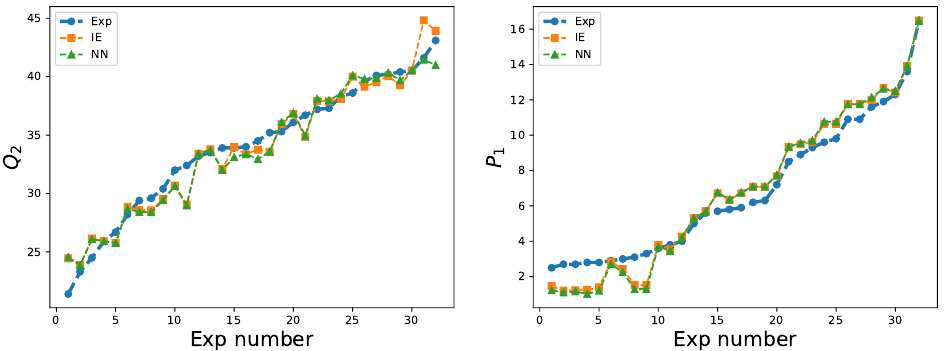
Figure 8. Predicted values of Q 2 ( left ) and P 1 ( right ) and the experimental data. Notations: Exp— experimental data from [35], IE—integral equation model and NN—neural network